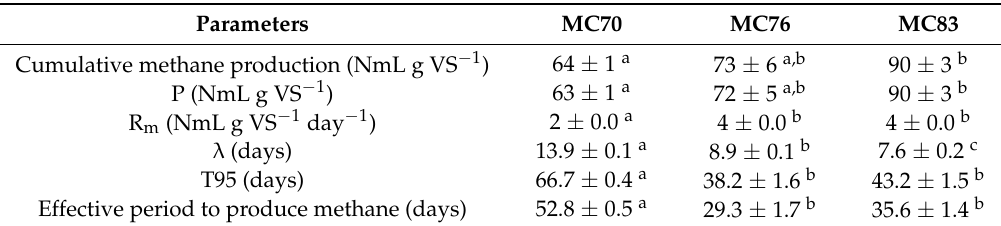
Table 4. Influence of initial feedstock moisture content on Gompertz and experimental parameters of cumulative methane yield from dairy manure. ( a,b,c Values are means ± SE, n = 3. Means with different superscripts are significantly different ( p < 0.05)).